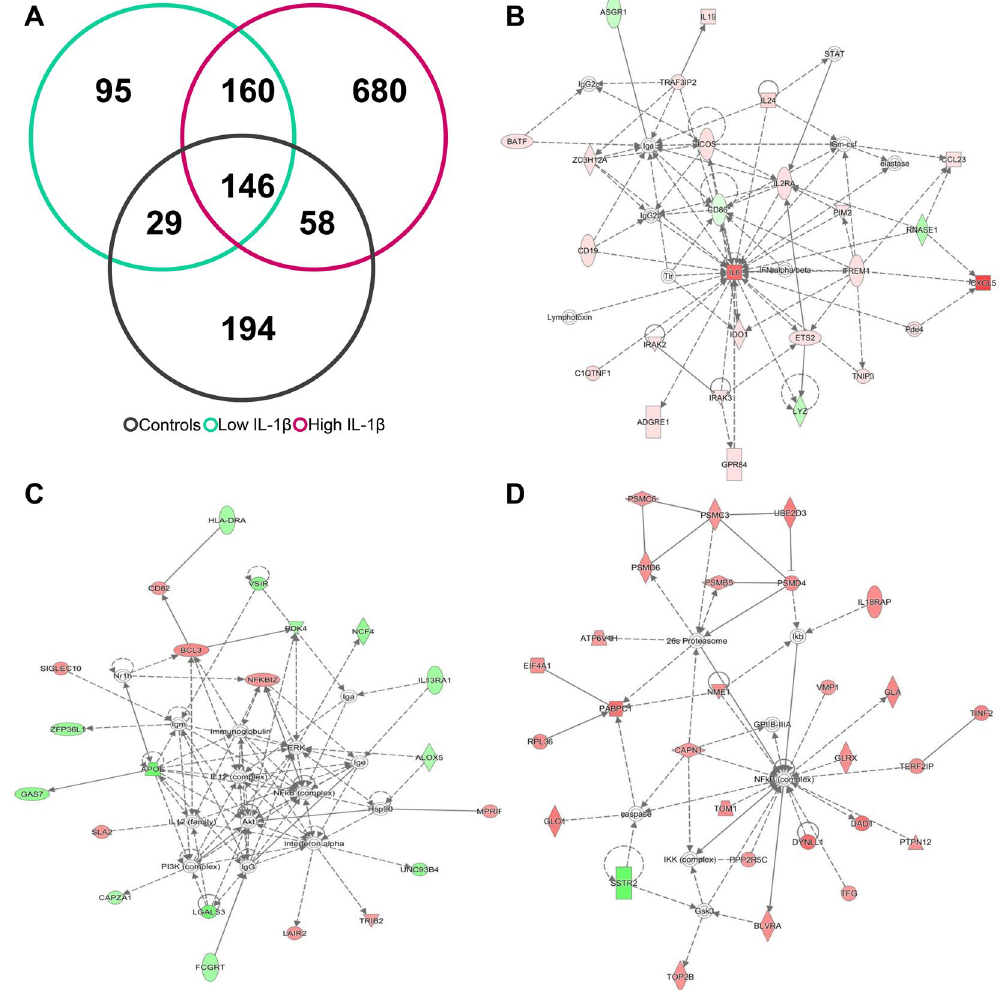
basal levels of IL-1 β . ( B ) Network obtained after taking common genes to all groups. ( C ) Network obtained after taking MD patients with low basal levels of IL-1 β unique DEG. ( D ) Network obtained after taking MD patients with high basal levels of IL-1 β unique DEG. Genes in red were up-regulated, while genes in green were down-